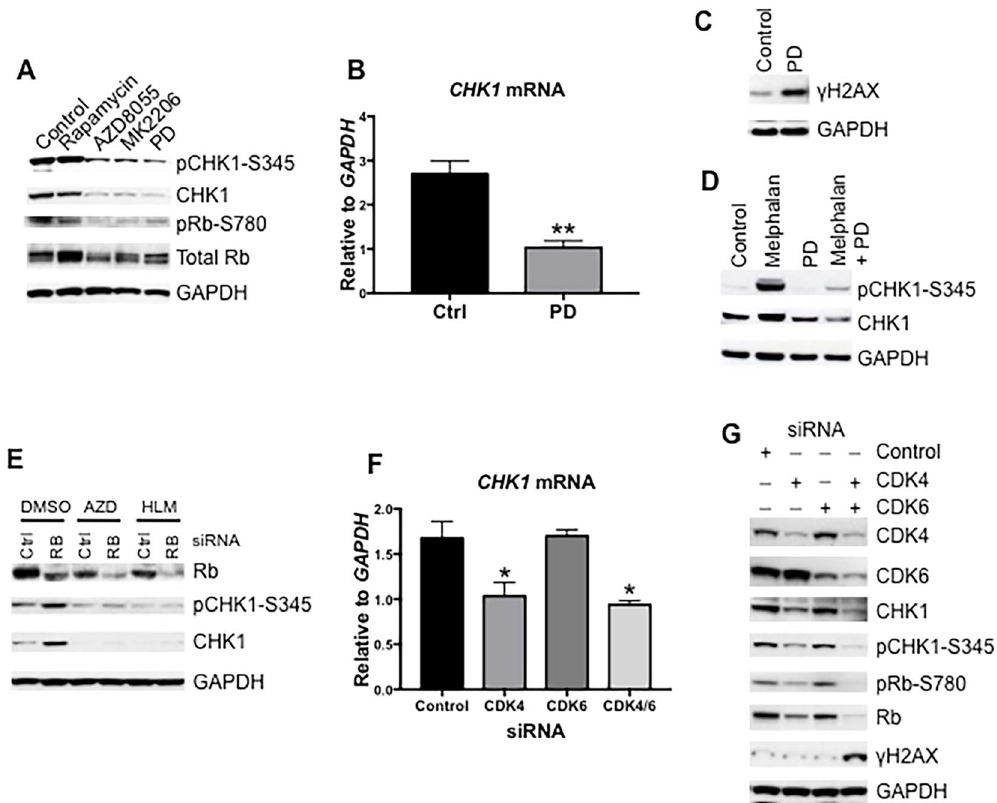
Figure 5. Inhibition of CDK4/6 Decreases CHK1 and Induces DNA Damage. ( A ) Rh30 cells were treated with rapamycin, AZD8055, MK2206 or PD03332991 (1 μ M) for 16 hr. Total proteins were extracted for immunoblotting. ( B ) Rh30 cells were treated with PD03332991 for 12 hr. The total RNA was extracted to detect CHK1 mRNA by real-time RT-PCR with GAPDH as internal control. Relative quantity of CHK1 mRNA was plotted. Error bars: Mean ± SD (n = 3). ** P < 0.01. ( C ) Rh30 cells were treated with PD03332991 for 16 hr. Total proteins were extracted for immunoblotting to detect γ H2AX. ( D ) Rh30 cells were treated with PD0332991 for 16 hr, then melphalan was added alone or in combination with PD0332991 and incubated for 5 hr. Immunblotting was done to determine CHK1, pCHK1-S345. ( E ) Rh30 cells were transfected with control (Ctrl) or RB siRNA. 24 hr later, AZD8055 (AZD, 1 μ M), HLM006474 (HLM, 10 μ M), or AZD8055 plus HLM006474 (AZD HLM) was added for additional 24 hr. Total proteins were extracted for immunoblotting. ( F ) Rh30 cells were transfected with siRNAs of control, CDK4, or CDK6. 72 hr later, total RNA was extracted to detect CHK1 mRNA by real-time RT-PCR with GAPDH as internal control. Relative quantity of CHK1 mRNA was plotted. G, Rh30 cells were treated as in Fig. 5F, total proteins were extracted for immunoblotting. GAPDH served as loading controls. Immunoblots were converted to gray with auto tone by Photoshop